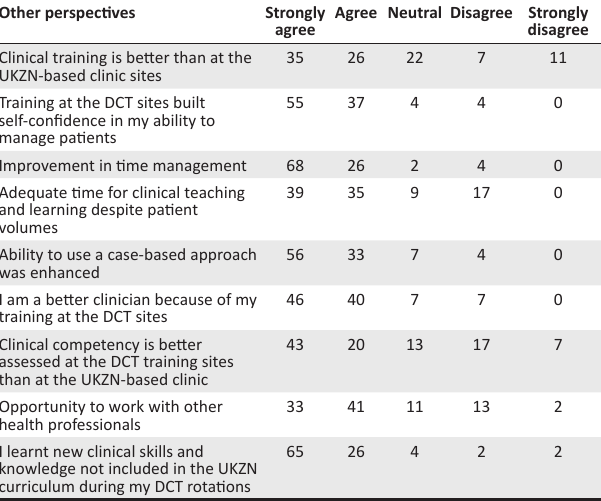
FIGURE 3: Perceptions of equipment available to students at decentralised clinical training sites.